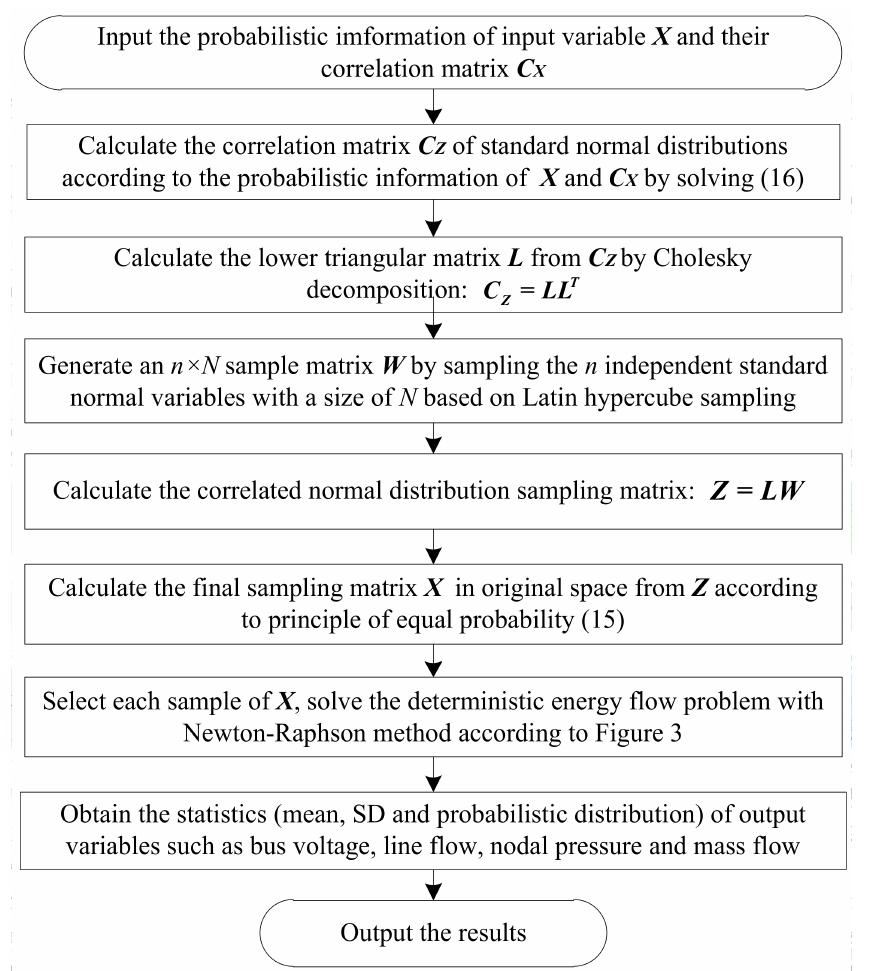
Figure 4. Flowchart for solving the PEF problem of an EGH-IES based on